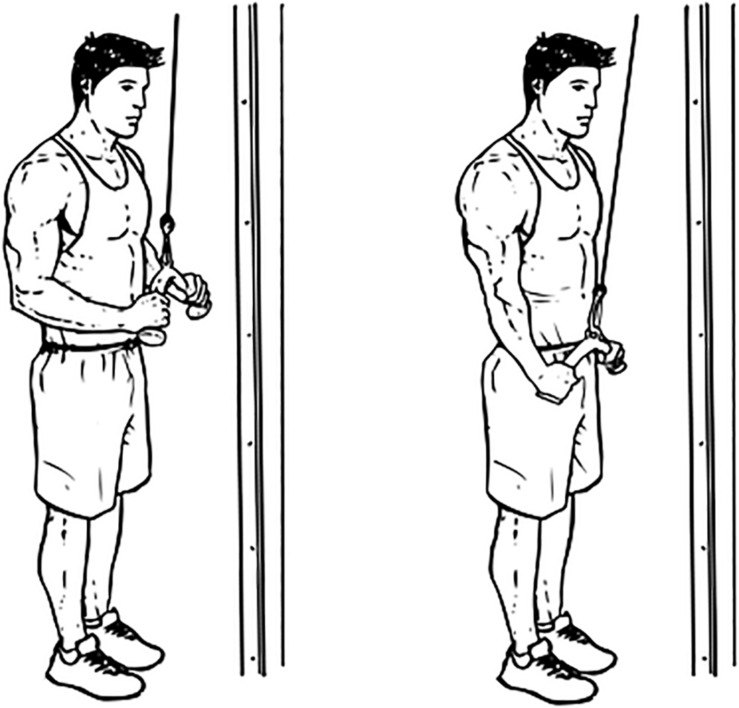
Triceps push-down exercise (source: www.workoutlabs.com).